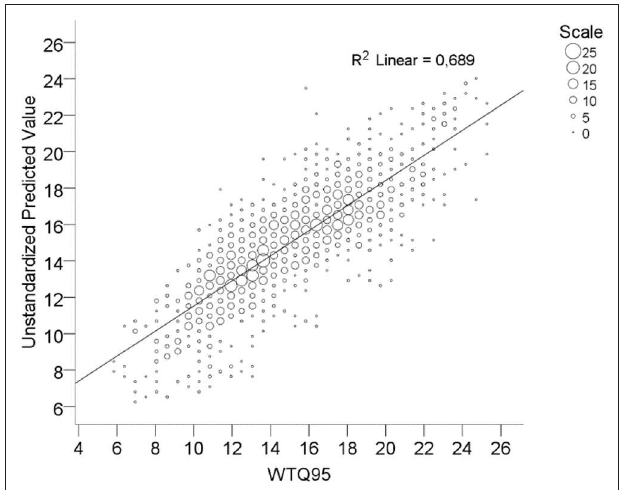
FIGURE 3 | Linear relation of observed and predicted (unstandardized) WTQ95 values ( n = 1,831) in ( ◦